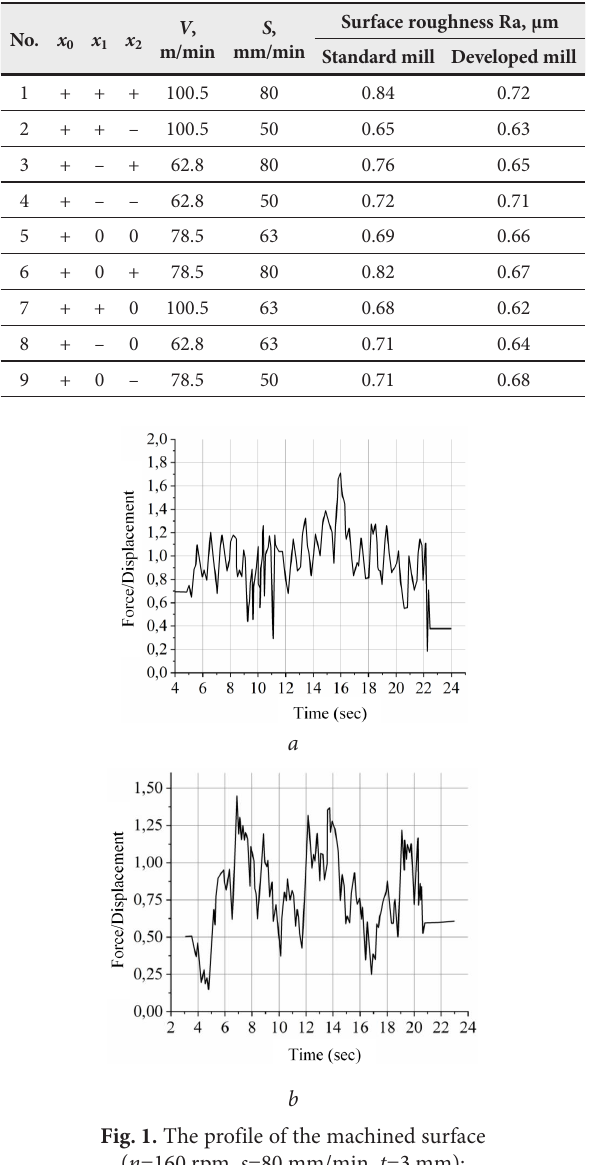
Fig. 1. The profile of the machined surface ( n =160 rpm, s =80 mm/min, t =3 mm): a – standard mill ( Ra 0,84 μm); b – developed mill ( Ra 0,72 μm) The influence of cutting modes on the surface roughness of parts made of titanium alloy VT1-0 ( Fig. 2 ).